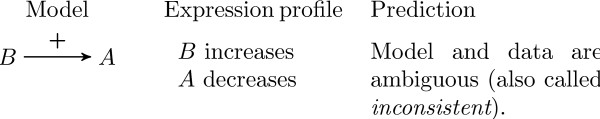
A simple case of inconsistency between some data and a model.